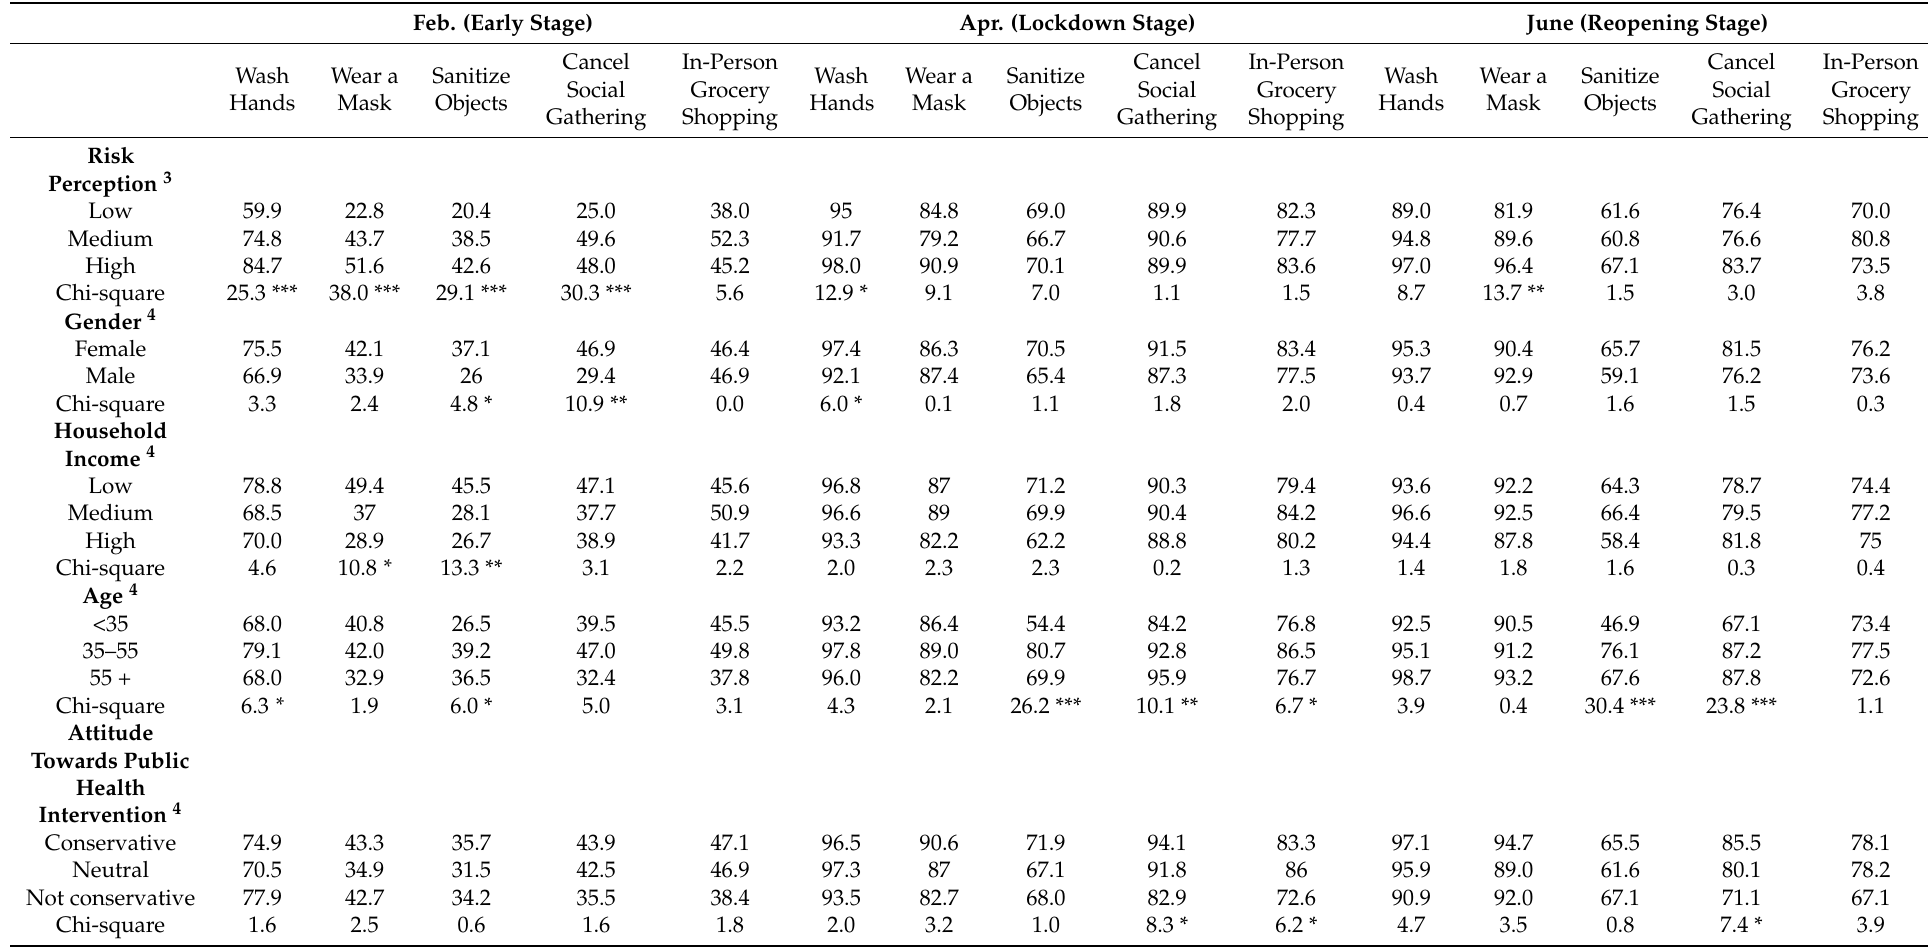
Table 2. Cross-tabulation between prevention practices and individual characteristics across three timelines: percentage 1 and chi-square value 2 . Feb. (Early Stage) Apr. (Lockdown